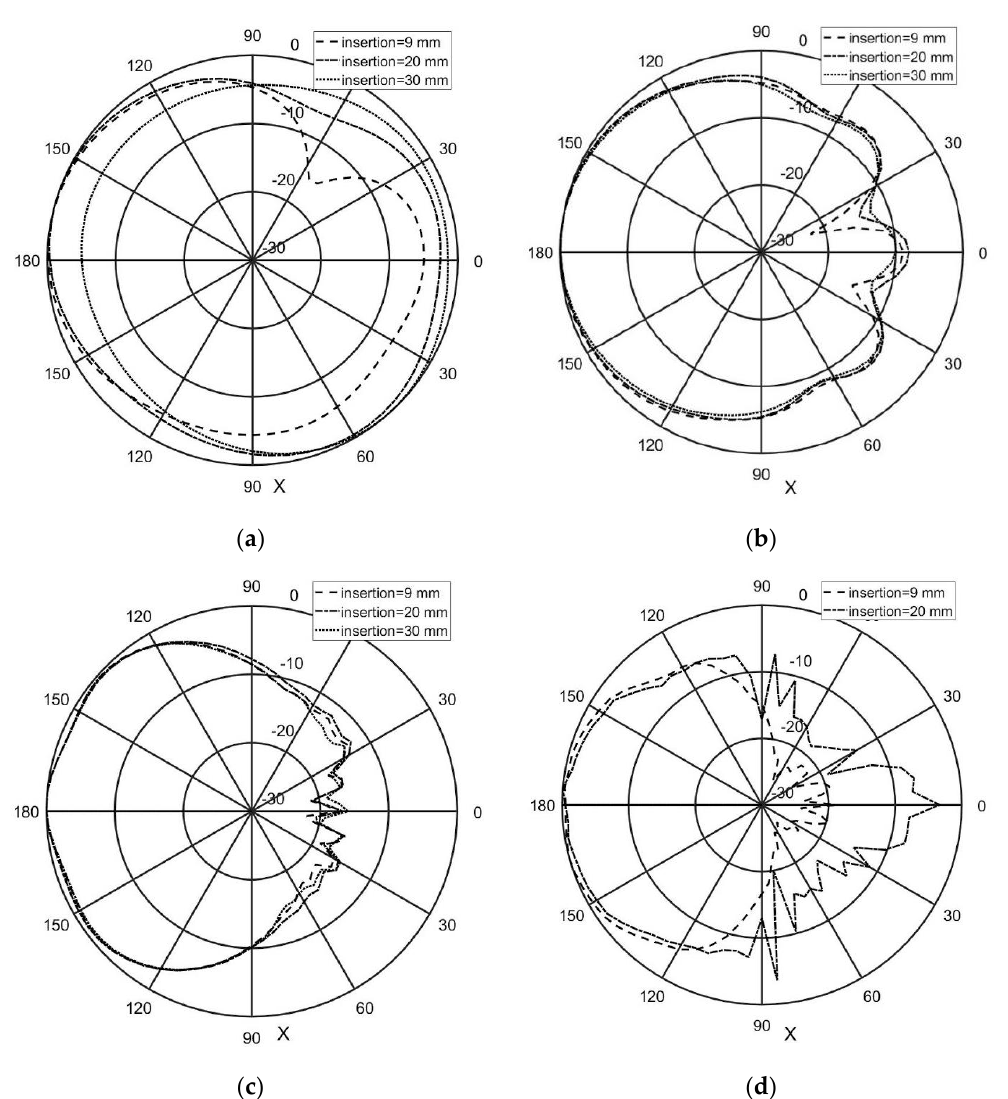
Figure A2. Normalized gain pattern with insertion distance of antenna 1 on the horizontal plane: ( a ) f = 402 MHz, ( b ) f = 868 MHz, ( c ) f = 2.45 GHz and ( d ) f = 5.8 GHz (only two insertion distances are shown as the noise is dominant above 20 mm at this frequency).